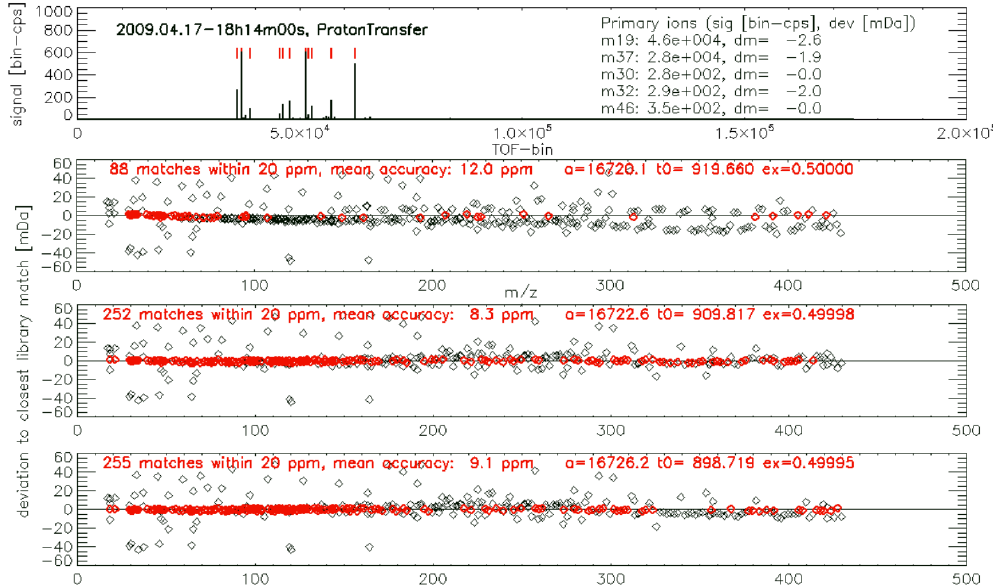
Figure 2. The top chart shows the SumSpectrum, the largest 16 peaks are marked in red. For better visibility the SumSpectrum has been truncated by setting high values equal to 10% of the maximum value. Charts 2–4 demonstrate the quality of the three methods of mass scale calibration (see text for details): each point represents a detected peak (ion mass, Da, on the x axis). The peaks were compared with the compound library. The y axis shows deviation to the closest library match (in mDa). The quality of the scale conversion is assessed by the number of matches (red data) with library compounds. The mass scale calibration is the best for method 3 (chart